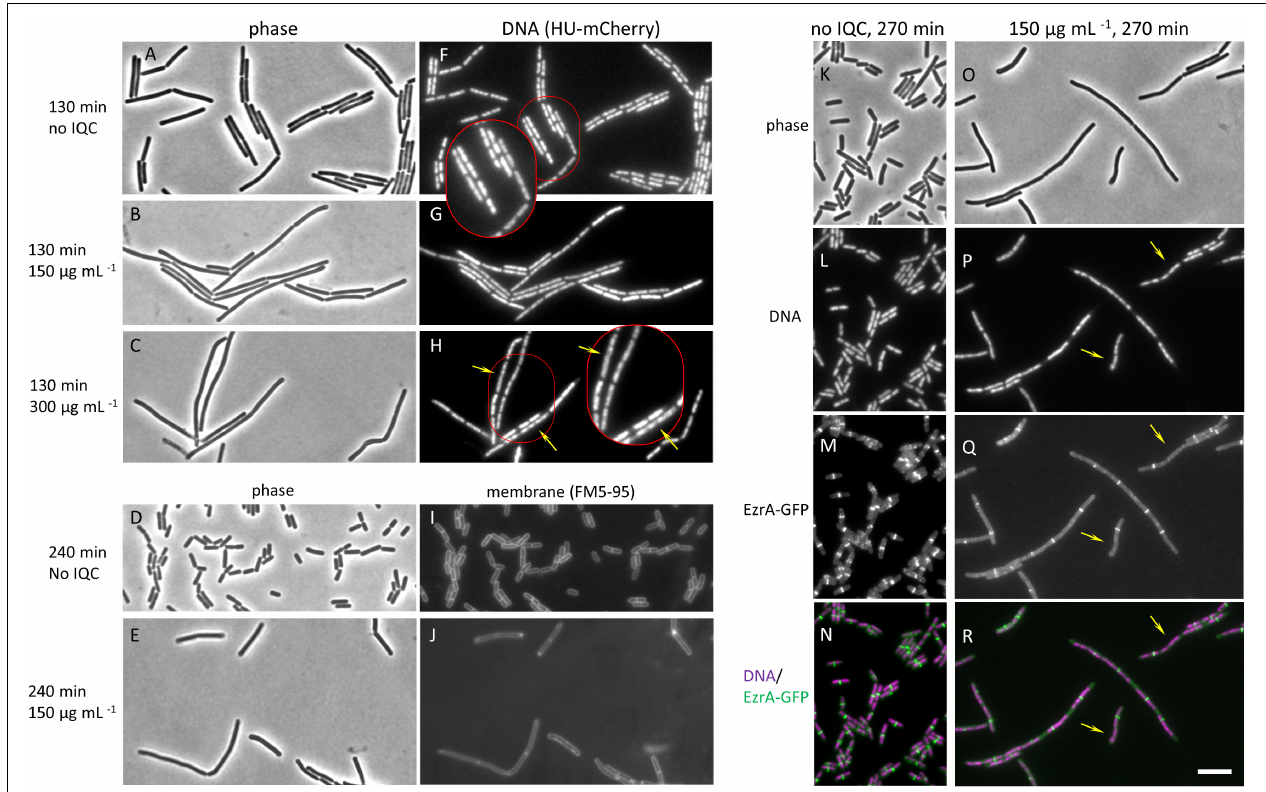
FIGURE 2 | Effects of IQC on cell morphology. (A–C) and (F–H) Effects of different concentrations of IQC on B. subtilis cells. The wild type strain 168ca, carrying an ezrA-gfp fusion (native promoter at native locus) and an Hbsu-mCherry fusion (at amyE ; for labeling DNA), was grown in the presence of IQC or 0.01% DMSO at 30 ◦ C for 130 min. (A–C) phase contrast images. (F–H) images of Hbsu-mCherry showing the nucleoids. (A,F) no IQC (0.01% DMSO). (B,G) 150 µ g mL − 1 IQC. (C,H) 300 µ g mL − 1 . Arrows in H point to elongated nucleoids. (D,E,I,J) Effect of IQC treatment on cell length. Wild type strain 168ca grown in LB was treated with 150 µ g mL − 1 IQC for 240 min at 30 ◦ C. Membranes were stained with membrane dye FM5-95. (D,E) Phase contrast images. (I,J) images of membranes. (K–R) Effect of IQC treatment on the localization of early cell division protein EzrA. The wild type strain 168ca, carrying an ezrA-gfp fusion (native promoter at native locus) and an Hbsu-mCherry fusion (at amyE ; for labeling DNA), was grown in the presence of IQC (O–R) or DMSO (K–N) at 30 ◦ C for 270 min. (K,O) Phase contrast images. (L,P) Images of Hbsu-mCherry showing the nucleoids. (M,Q) Images of EzrA-GFP used as a marker for the localization of cell division protein FtsZ. (N,R) Overlay of Hbsu-mCherry and the EzrA-GFP images. EzrA-GFP is shown in green and DNA in magenta. Arrows point to locations where EzrA localization is perturbed or absent and chromosome are not properly segregated. The inserts show the enlarged images of the cells circled in red in panels (F,H)